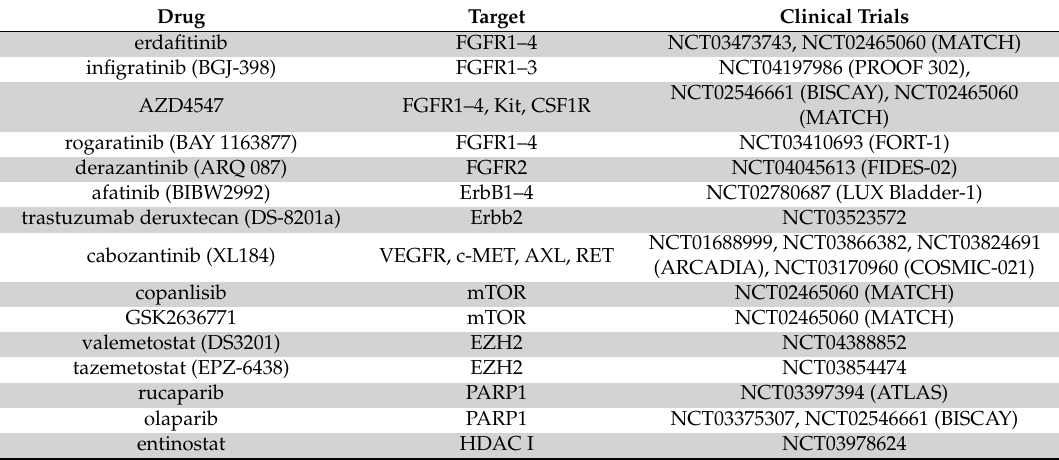
Table 1. Targeted therapies that are currently being investigated in